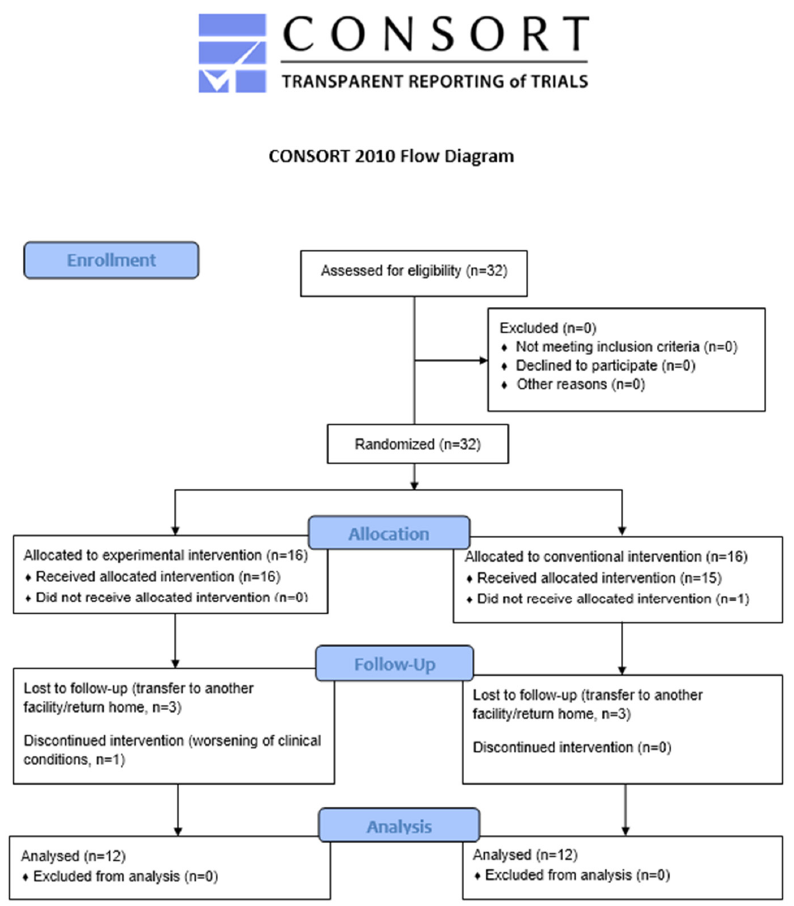
Figure 2. The CONSORT flowchart.